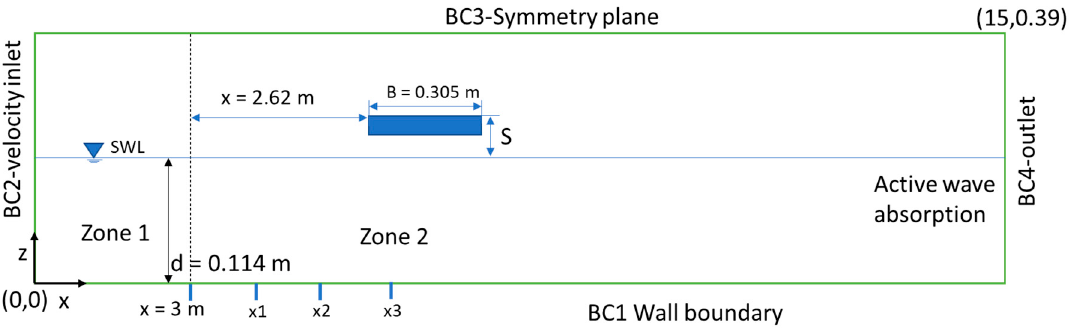
Figure 1. Numerical model set up of experimental wave tank (Seiffert et al., 2014) for validation.